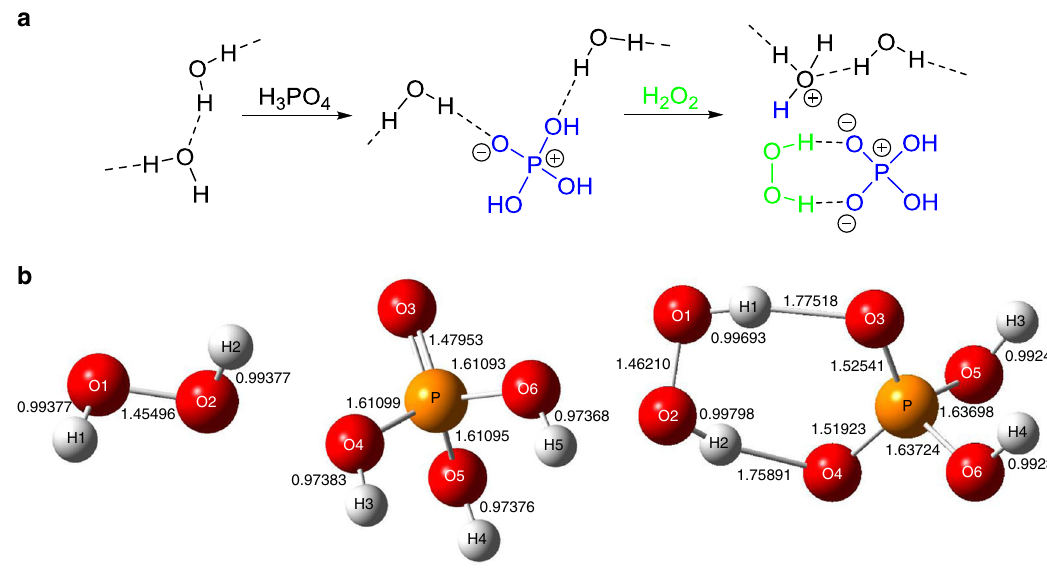
Fig. 5 Schematic representation of H-bonding interaction and optimized structures of compounds. a Sequential change in H-bonding interaction between water, H 2 PO 4 − , and H 2 O 2 . b optimized structures of H 2 O 2 , H 2 PO 4 − , and H 2 O 2 – H 2 PO 4 − complex (DFT/B3LYP/6 – 31 G*(d), PCM: water).